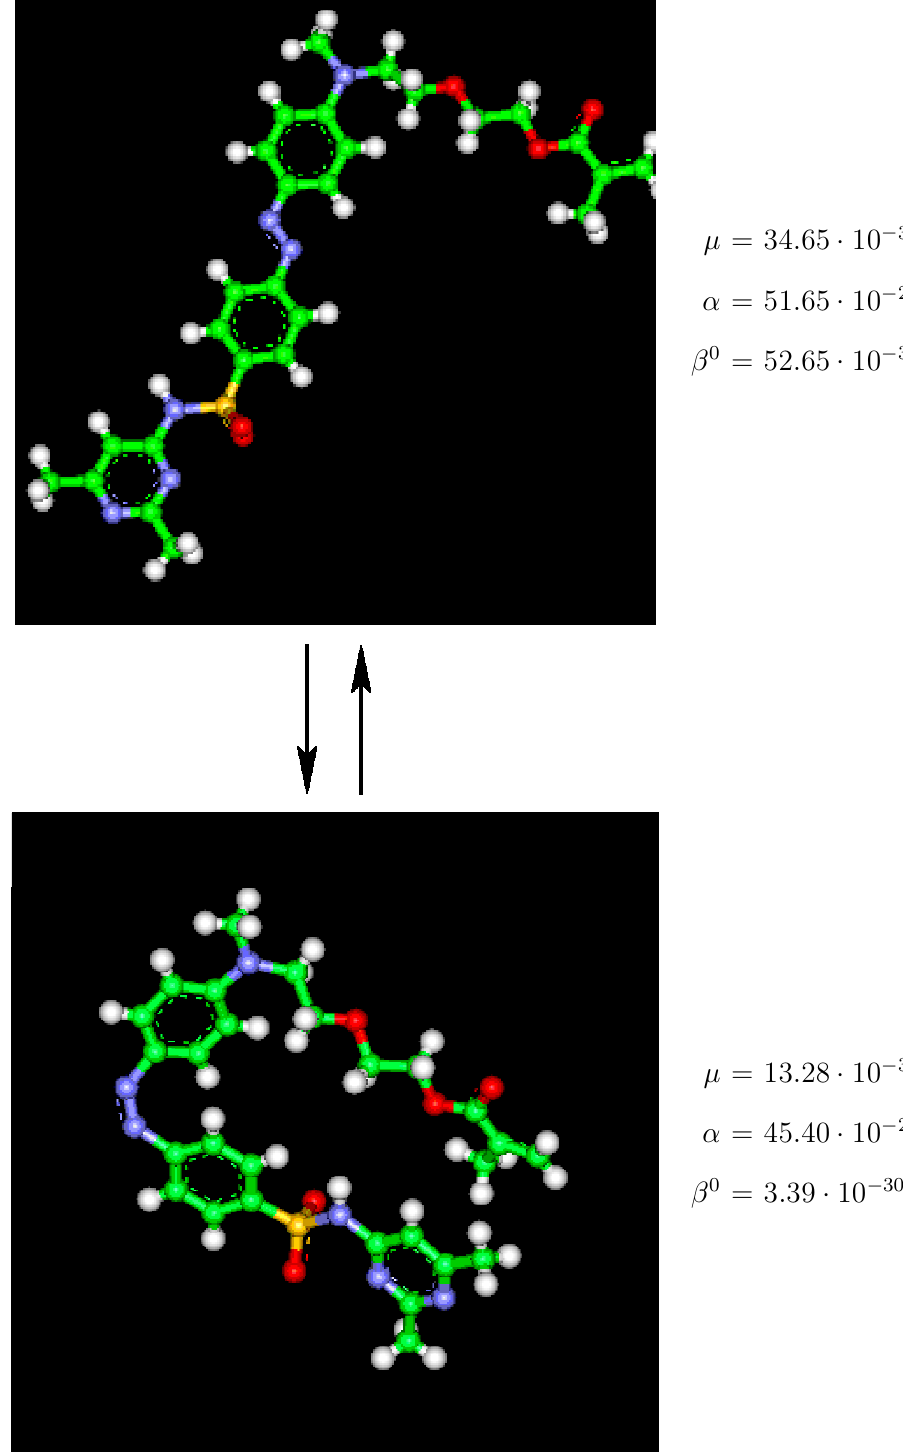
Fig. 3 Optimized trans and cis isomers of monomer IZO-3 as calculated by GAUSSIAN